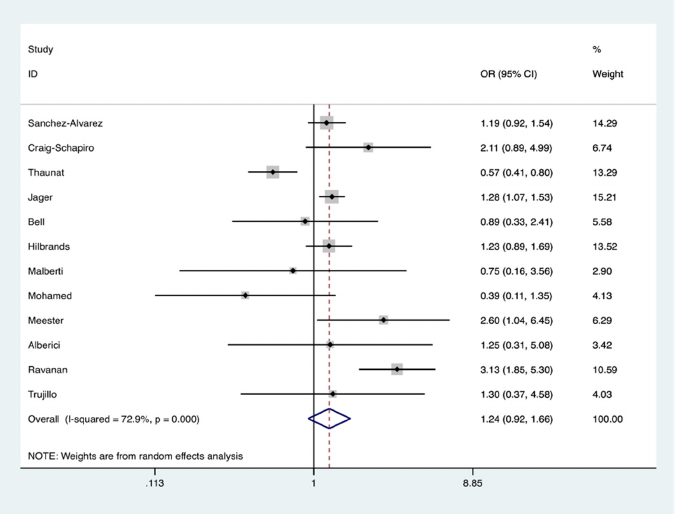
Figure 6. Forest plot depicting COVID-19 associated mortality risk in chronic kidney disease (CKD) patients on waitlist/dialysis in contrast to kidney transplant recipients. The diamond shows no increased risk of death; OR 1.24 represented by red dashed line with the edges of the blue diamond representing 95% confidence intervals (0.92–1.66). OR: Odds